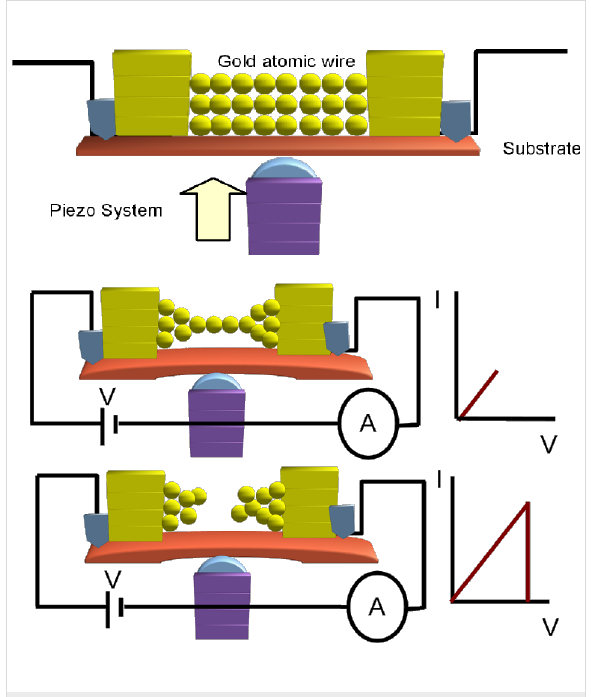
Figure 1: Schematic illustration of the MCBJ technique and the method of current-induced breaking. The top panel (not to scale) shows the initial configuration of a metal wire with a notch formed in the middle of the wire, and mounted in a three-point bending configur- ation. The middle panel illustrates the formation of an atomic chain after stretching the wire electrodes. The black lines represent the wires that connect the atomic sized structure to the bias voltage and to a current–voltage converter for recording the current. The small current–voltage diagram on the right emphasises that the currents and voltages remain low in this phase of the experiment. The bottom panel illustrates the current-induced breaking of the atomic